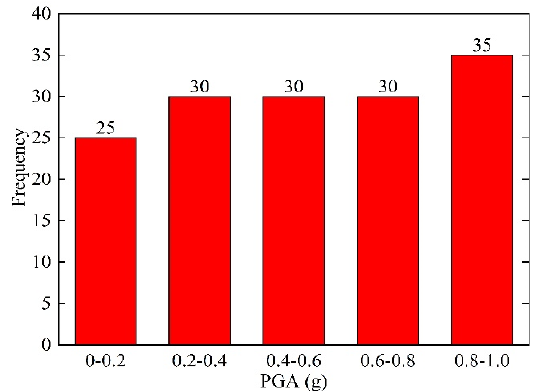
Figure 5. PGA distribution.